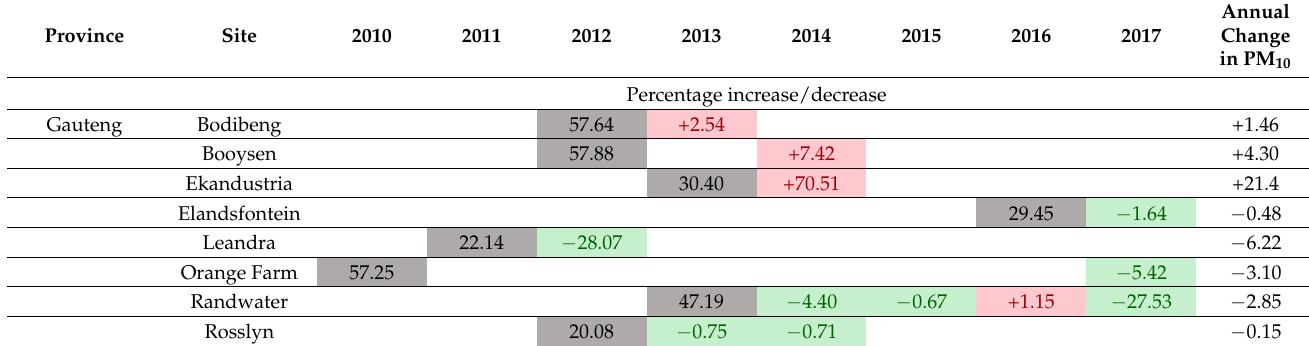
Table 1. Levels and changes in annual PM 10 µ g/m 3 concentrations across sites for the years 2010–2017. The first entry per site shows the annual PM 10 concentration in µ g/m 3 . Subsequent entries depict the percentage changes compared to the previous entry. The last column shows the annual changes in µ g/m 3 per year assuming a linear trend between the first and last available measurement per site.